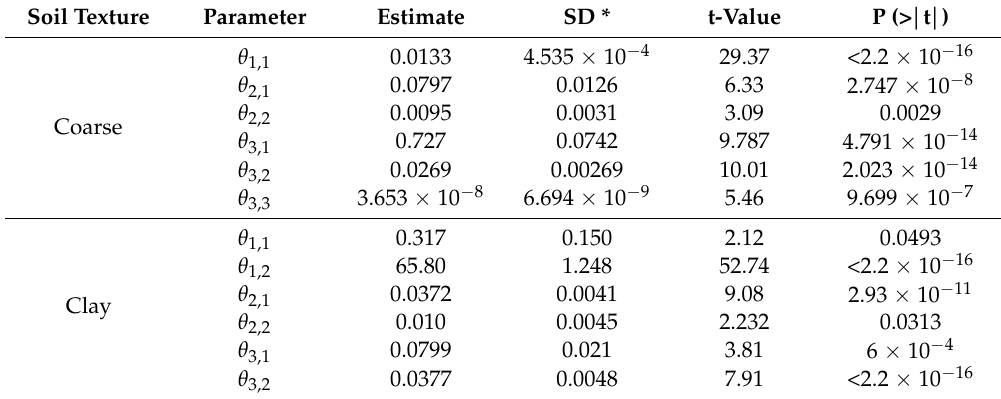
Table 1. Parameters and the associated statistics for the models describing the yield response to soil test P (STP), P and N fertilization on coarse and clay soils as per Equations (15) and (16) †